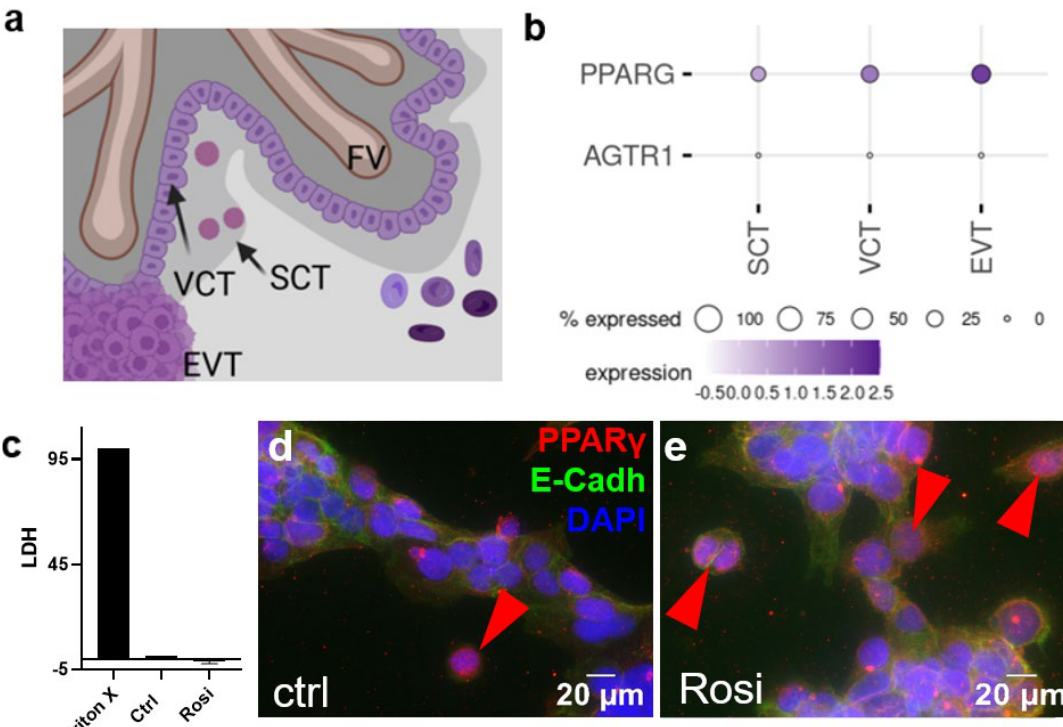
Figure 1. ( a ) Schematic drawing of trophoblast subpopulations assessed by single-cell RNA-sequencing in panel b. ( b ) Expression pattern of possible binding sites for AGTR1-blocker candesartan at the maternal–fetal interface in human first-trimester placenta (single-cell RNA sequencing data from Vento-Tormo et al. published 2018 in Nature ) [33]. ( c ) The LDH assay was performed with the supernatants of BeWo cells treated with 5 µM of rosiglitazone for 24 h and the respective controls. BeWo cells were stained for E- cadherin (green) and PPARγ (red). Vehicle control - (DMSO 0.5% v/v ) ( d ) and rosiglitazone- (5 µM) ( e ) treated BeWo cells showed few PPARγ -stained nuclei after 24 h incubation. A double immunofluorescence staining with E-cadherin for trophoblast cell–cell con- tacts and PPARγ showed PPARγ -positive nuclei in the controls (arrowheads).